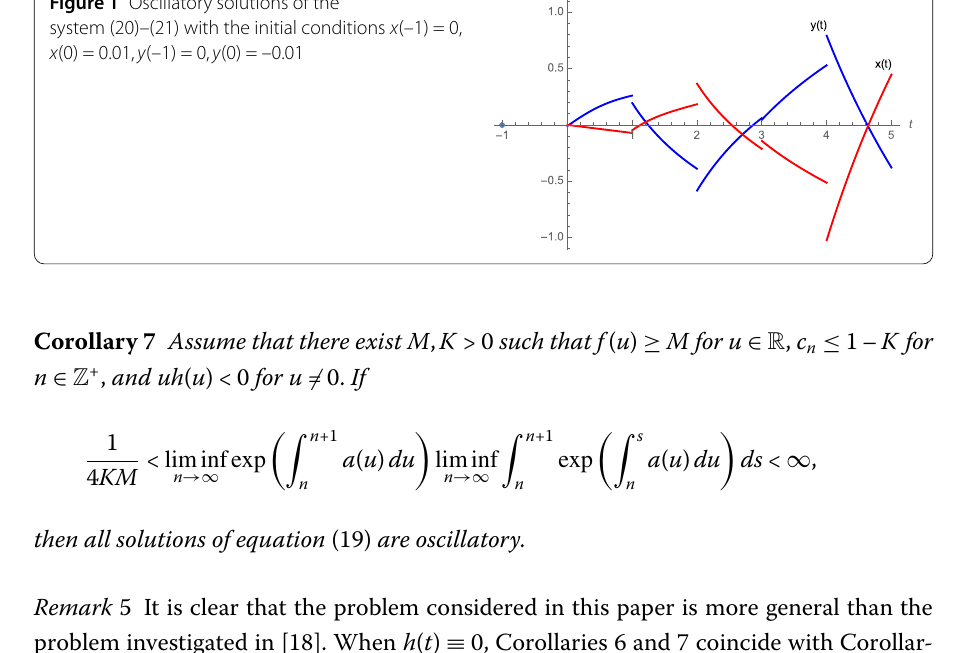
Figure 1 Oscillatory solutions of the system (20)–(21) with the initial conditions x (–1) = 0, x (0) = 0.01, y (–1) = 0, y (0) =